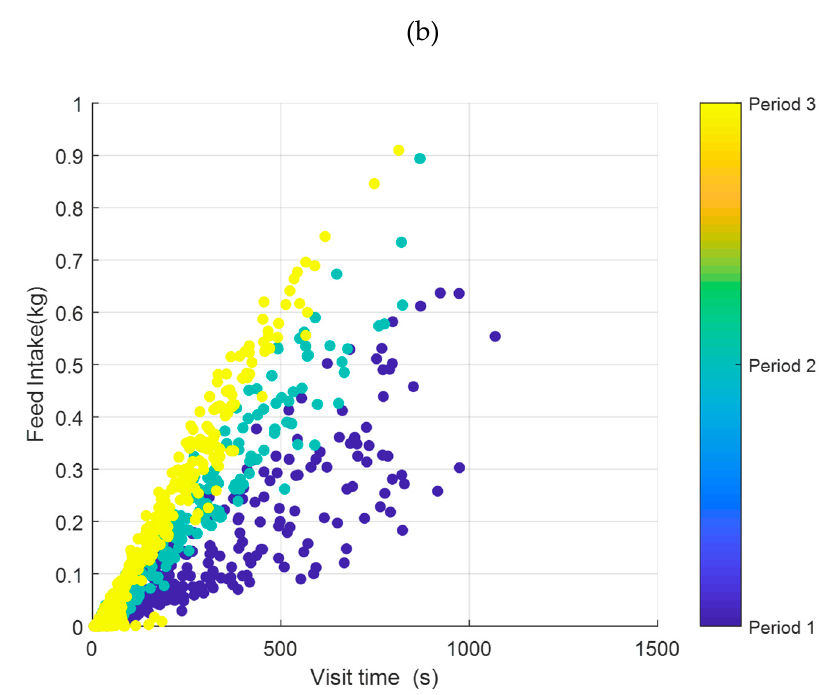
Figure 11. Feeding behavior in terms of visit duration and feed intake during the different periods for pigs tagged as ( a ) 6212 and ( b ) 6215.